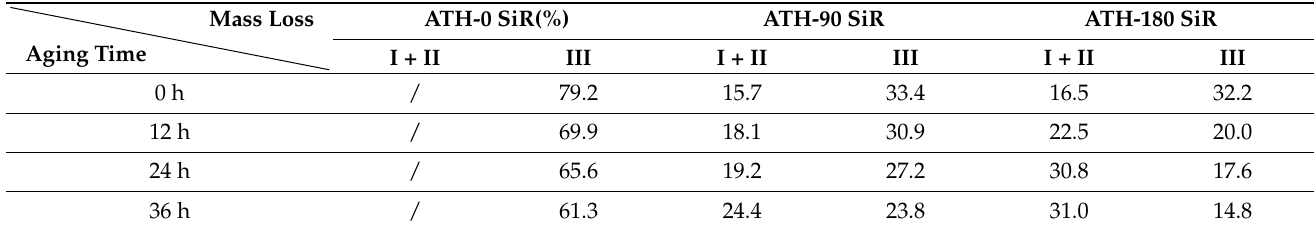
Table 1. The mass loss of ATH-0 SiR, ATH-0 SiR, and ATH-0 SiR. Mass Loss ATH-0 SiR(%) ATH-90 Aging Time